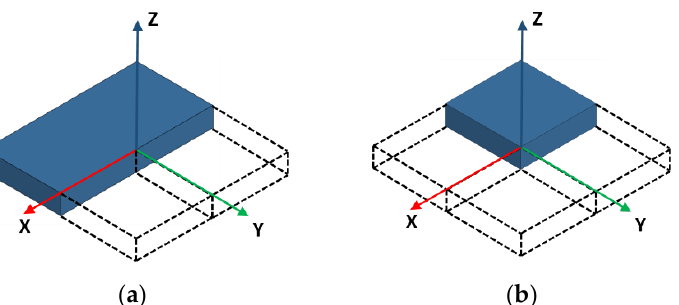
Figure 9. A battery cell model using a partial modelling technique: ( a ) half model; ( b ) quarter model.